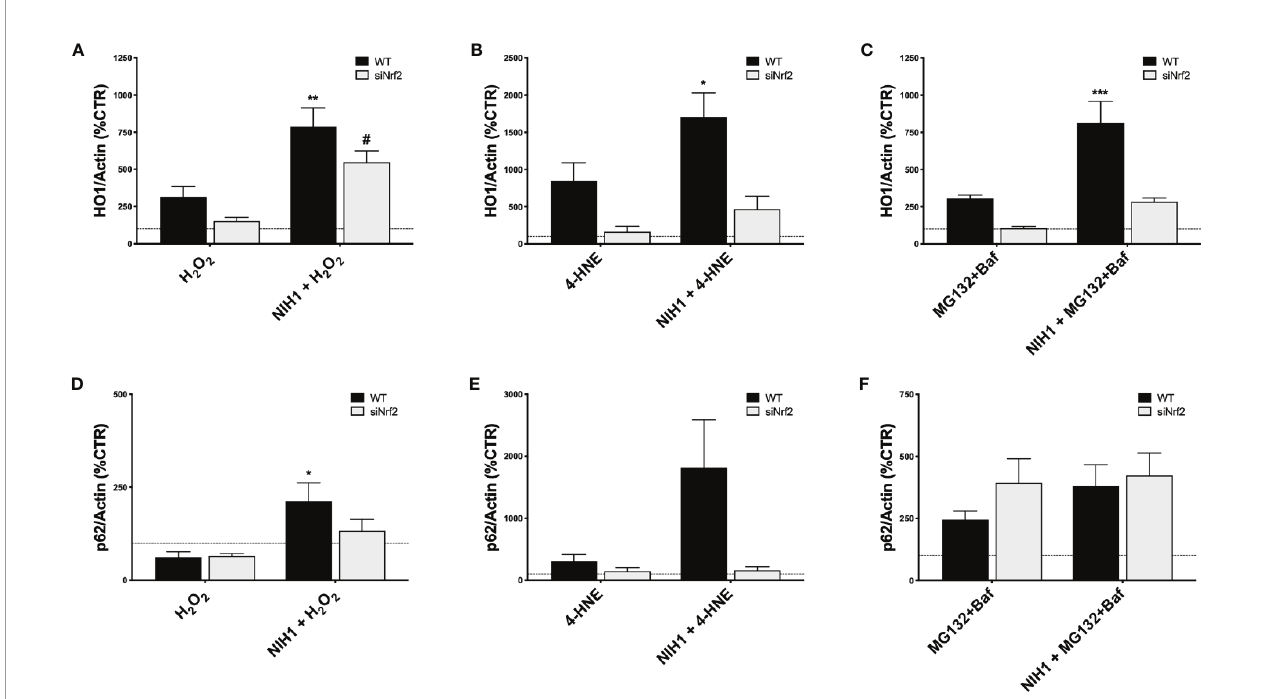
FIGURE 7 | NIH1-mediated modulation of HO1 and p62 protein expression in stressed WT and siNrf2 ARPE-19 cells. Both WT and siNrf2 ARPE-19 cell lines were pre-treated for 24 h with either solvent (DMSO, CTR), or NIH1 [5 m M], and then stressed, or not, for 6 h with H 2 O 2 [300 m M] (A , D) , 4-HNE [50 m M] ( B , E ), or MG132 + Ba fi lomycin [5 m M + 50 nM] (C , F) . Total cellular homogenates were examined by Western blot using antibodies against HO1 (A – C) and p62 (D – F) ; Actin content was used as a loading control to normalize the data. Results are expressed as percentage means ± SEM in comparison with control (dot line, 100%). Sidak ’ s multiple comparisons test; *p < 0.05, **p < 0.01; and ***p < 0.001 versus WT stress; # p < 0.05 versus siNrf2 stress; n = 4 –